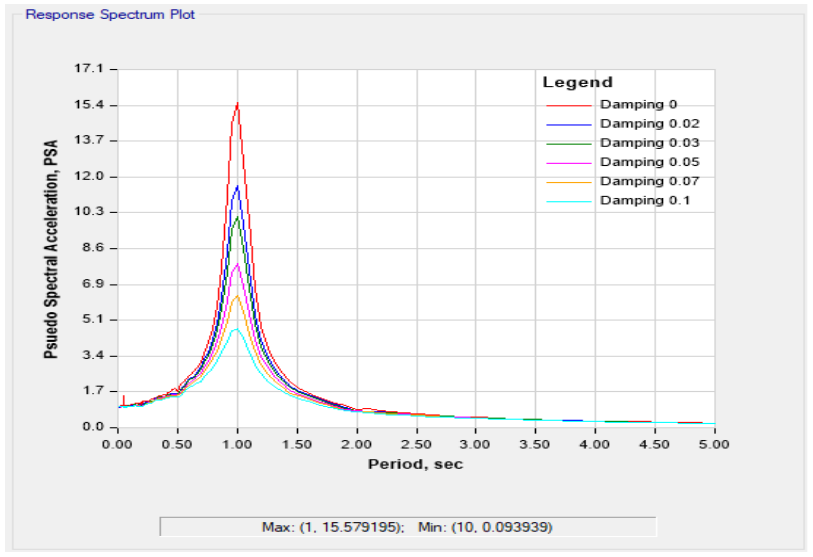
Figure 13. Pseudo spectral acceleration vs. period plot.